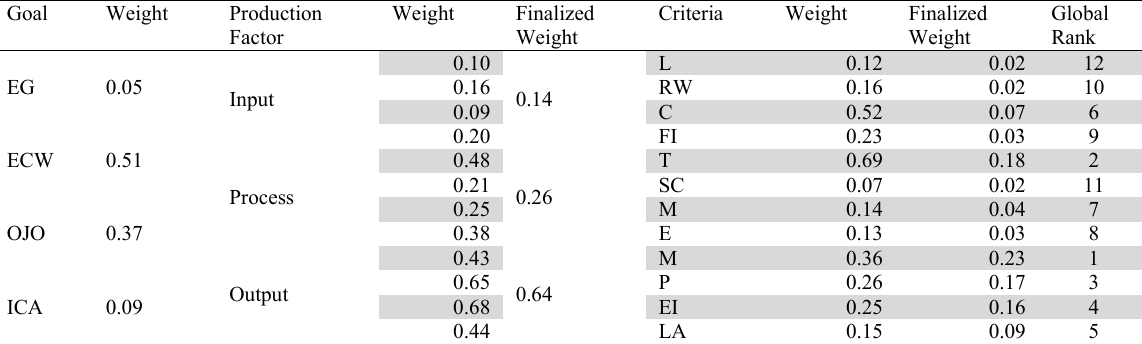
Final ranking of top fisheries sub-sector for each sub-districts in Southeast Maluku Goal